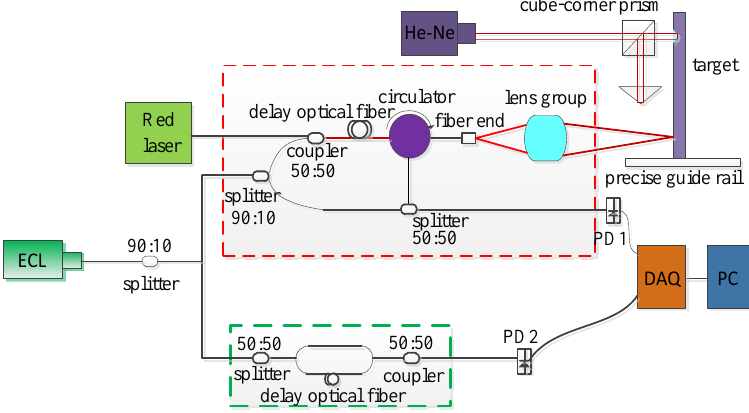
Figure 1. Schematic diagram of our frequency scanning interferometry (FSI)-based system and the experimental setup.